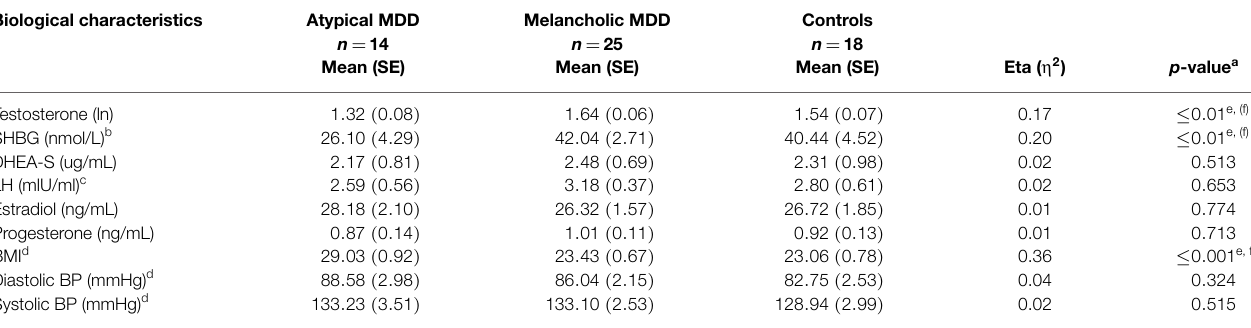
TABLE 2 | Biological characteristics of men belonging to the depressive subtypes derived from latent class analyses ( n = 39) and healthy controls ( n = 18), unadjusted . Biological characteristics